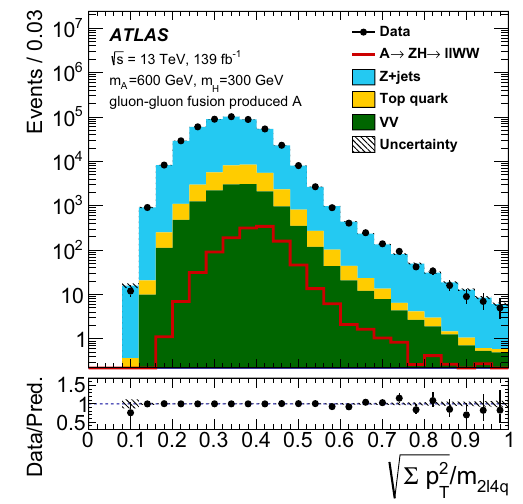
(cid:10) p 2 / m 2 (cid:6) 4 q distribution shown before the requirement T on this variable is applied. Corrections from a fit to the data are applied to the simulation, as described in Sects. 5.2 and 8. The notation VV in the legend corresponds to the production of diboson events. The signal distribution for ( m A , m H ) = ( 600 , 300 ) GeV is also shown, and is normalised such that the production cross section times the branching ratios B ( A → Z H ) and B ( H → WW ) corresponds to 1 pb. The lower panel shows the ratio of the data to the background prediction (black filledcircles)andtherelativeuncertainty,whichincludesbothstatistical and systematic components, in the background prediction (dashed